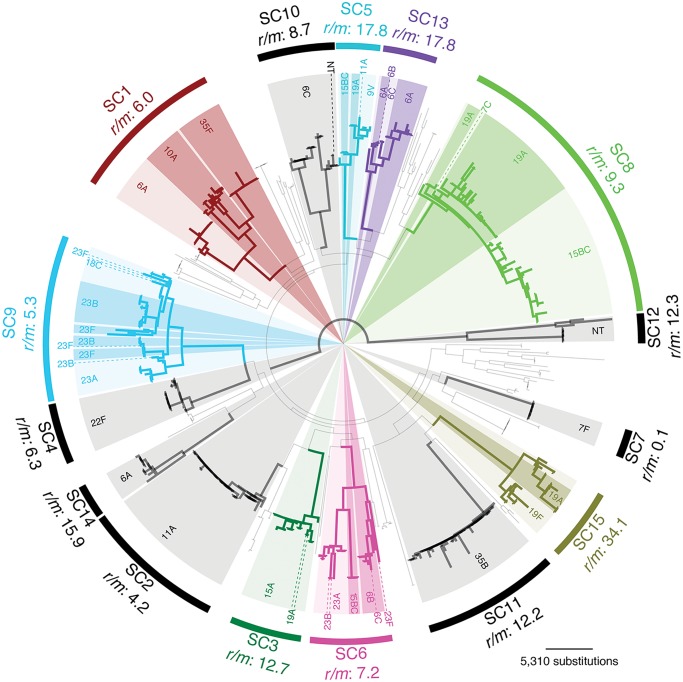
Prevalence of serotype switching in the overall population.The maximum likelihood phylogeny derived from a codon alignment of ‘core’ protein coding sequences is displayed, with fifteen monophyletic sequence clusters (SC1-SC15) labelled by arcs around the edge of the tree. Those sequence clusters in which no serotype switching was observed are marked by black arcs. Those sequence clusters in which multiple serotypes were observed are individually coloured, with the most prevalent serotype represented by light shading, and alternative serotypes indicated by darker shading or dashed lines.